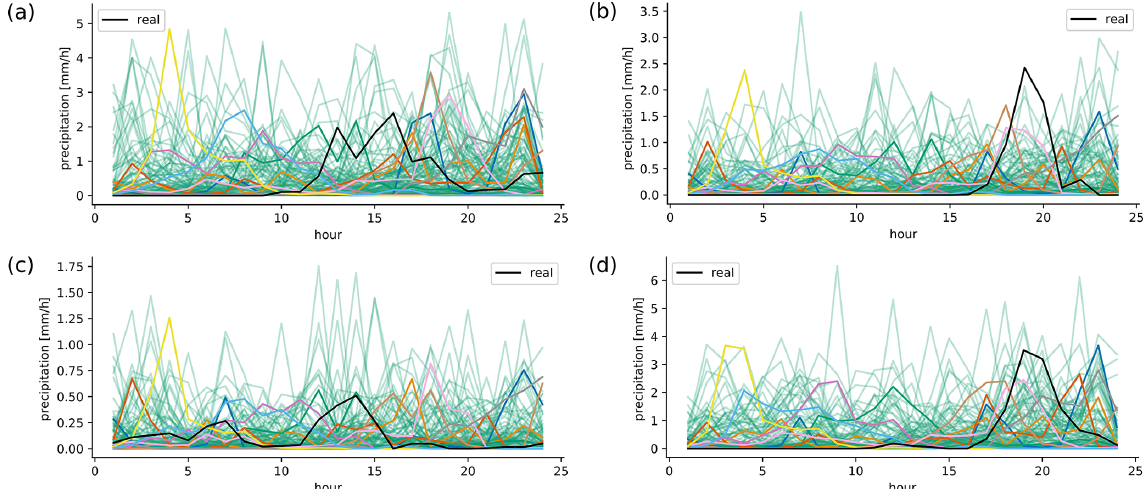
Figure 6. Examples of area-averaged precipitation scenarios over a single day. The black line shows the observed precipitation, and the green lines show 100 generated ones. The colored lines show 10 generated ones, where each color uses exactly the same noise in all four plots.